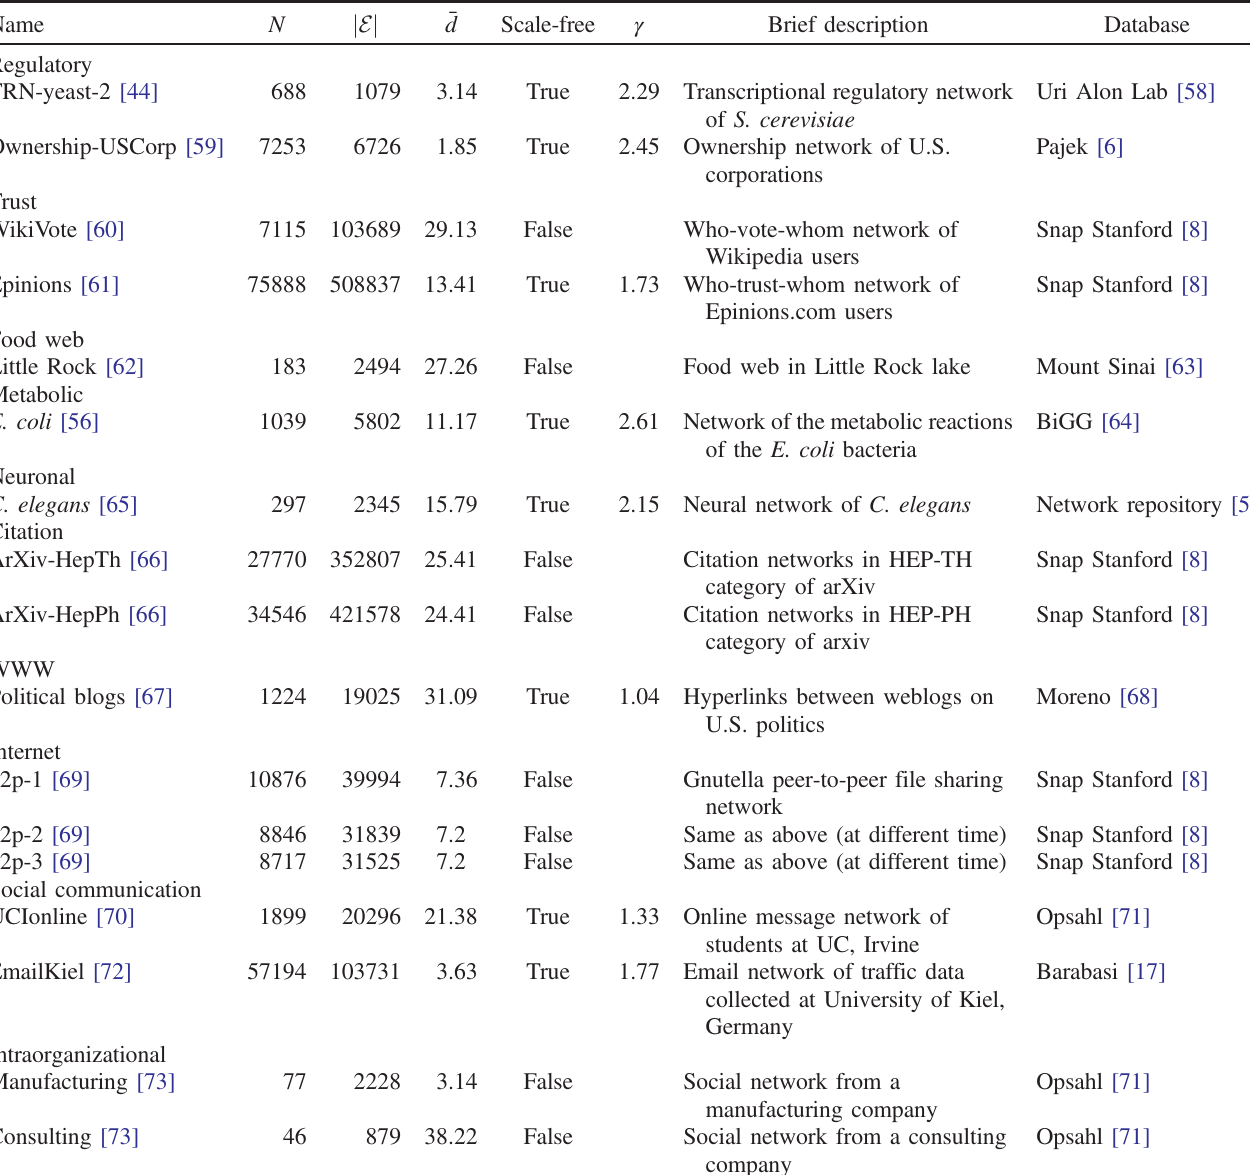
TABLE I. A compilation of networks from various fields, also examined by other authors [17]. Here, N is the number of nodes and j E j the number of edges. The column “ scale-free ” indicates whether the degree distribution shows a power law, and if so, the power law exponent γ is